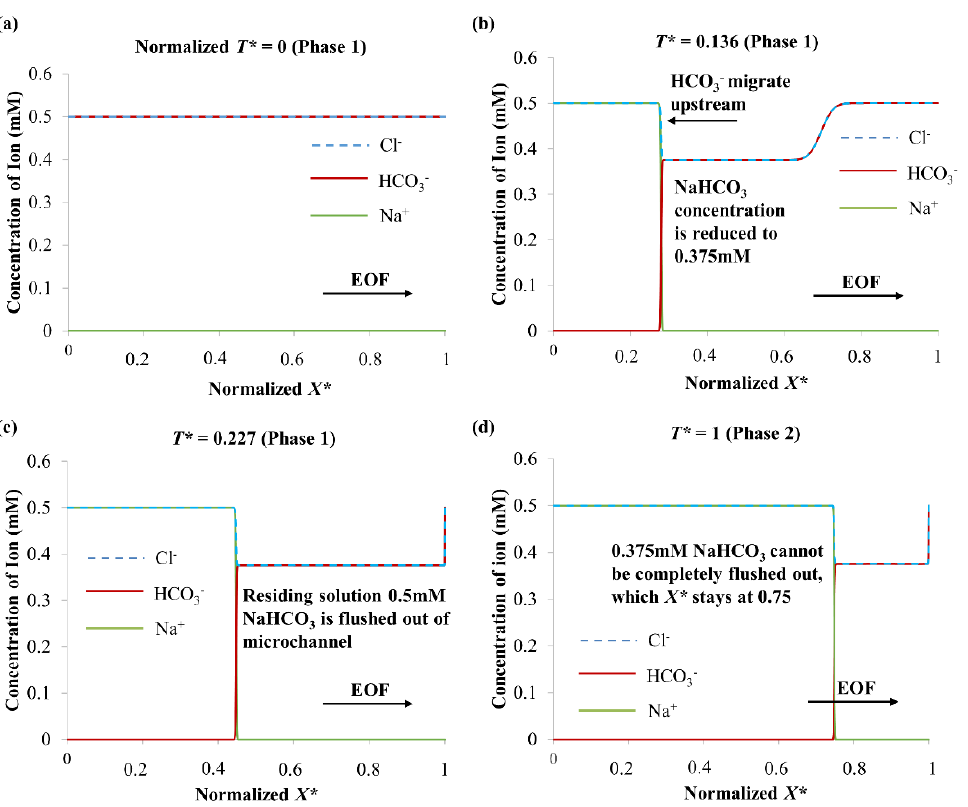
Figure 5. Numerically simulated ion concentrations along microchannel for 0.5 mM NaCl → 0.5 mM NaHCO 3 (the arrow indicates EOF direction) in ( a ) Phase 1 T* = 0, ( b ) Phase 1 T* = 0.136, ( c ) Phase 1 T* = 0.227 and ( d ) Phase 2 T* = 1. Normalized time T* = T / T SS NaCl → NaHCO 3 , where T SS NaCl → NaHCO 3 is time to reach steady-state current for NaCl → NaHCO 3 . Normalized X* = X / L , where X is axial coordinate and L microchannel